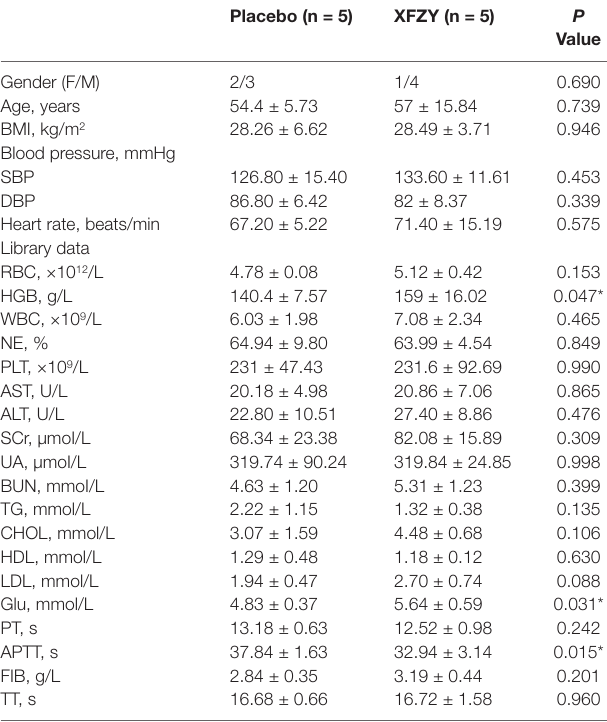
TABLE 2 | Baseline characteristics of